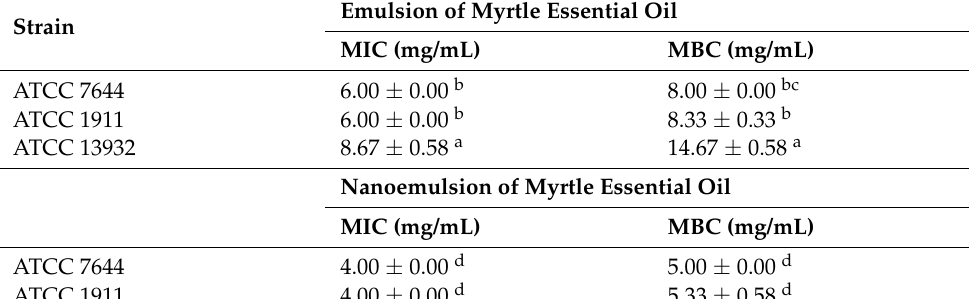
Table 2. Minimum inhibitory (MIC) and minimum bactericidal (MBC) concentrations of emulsion and nanoemulsion of myrtle essential oil against L. monocytogenes strains. Emulsion of Myrtle Essential Strain